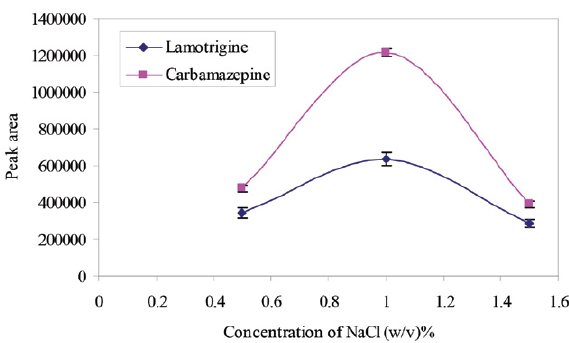
Figure 7. Effect of NaCl concentration on the extraction efficiency, Extraction conditions: extraction solvent: [C8MIM][PF6], extrac- tion solvent volume: 30 µL; dispersive solvent: methanol; dispersive solvent volume: 100 µL; pH: